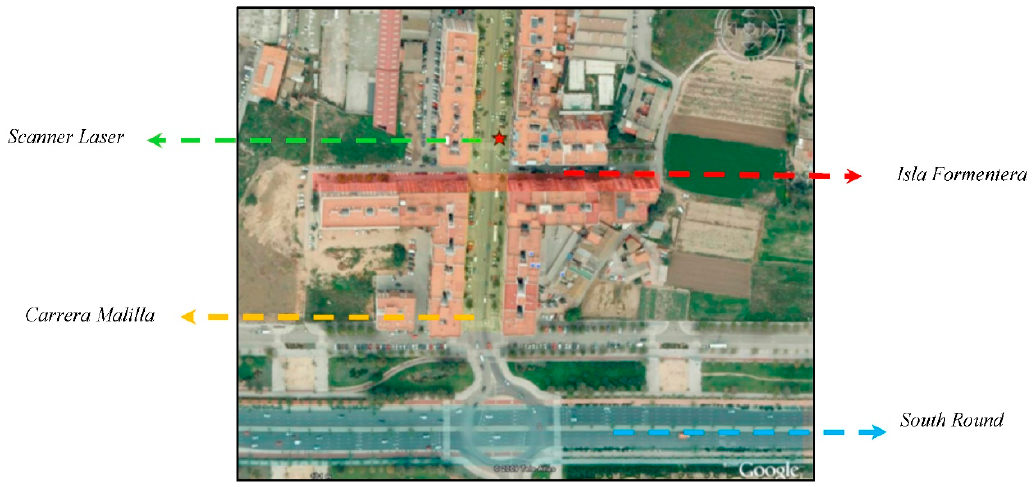
Figure 10. Satellite view of the area where the laser sensor was installed.